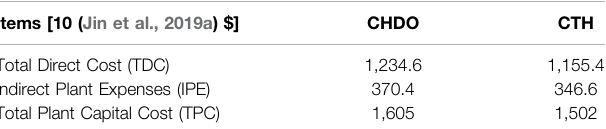
TABLE 5 | Capital cost of CHDO and CTH